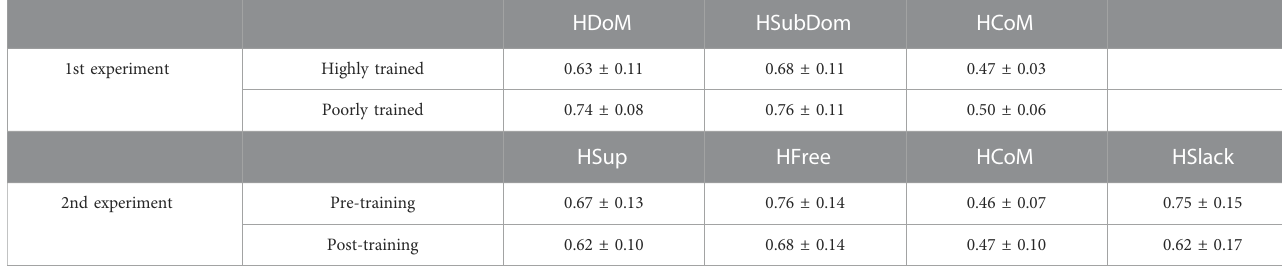
TABLE 1 Mean ± SD of the Hurst exponents of body and slackline acceleration from the two experiments.